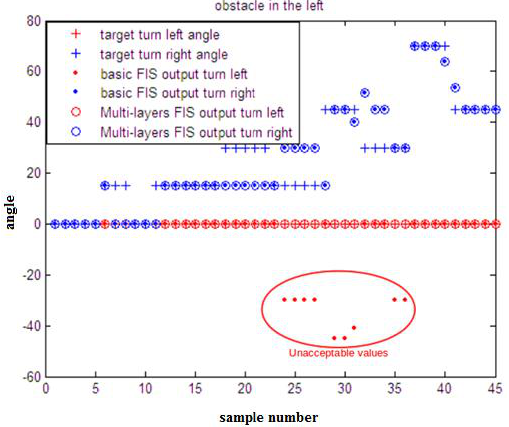
Fig. 16. Outputs of the multi-layer FIS and basic FIS and target angles when the obstacle is at the left When one layer FIS is compared with multi- layer FIS, it was observed that in some cases, basic one layer FIS presented unacceptable output